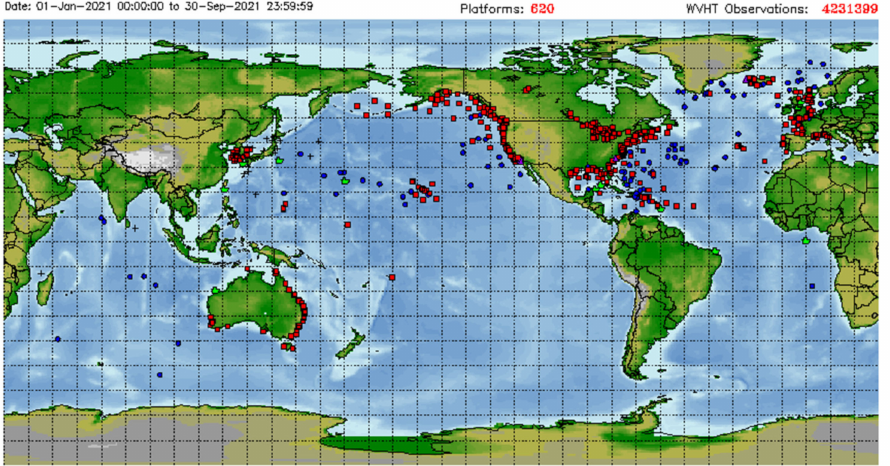
Figure 14. Global sea wave monitoring networks reporting on GTS during the first nine months of 2021; drifting buoys (blue dots), moored buoys (red squares), ships (green icons), others (black crosses). Map generated by: http://osmc.noaa.gov/Monitor/OSMC/OSMC.html (accessed on 29 October